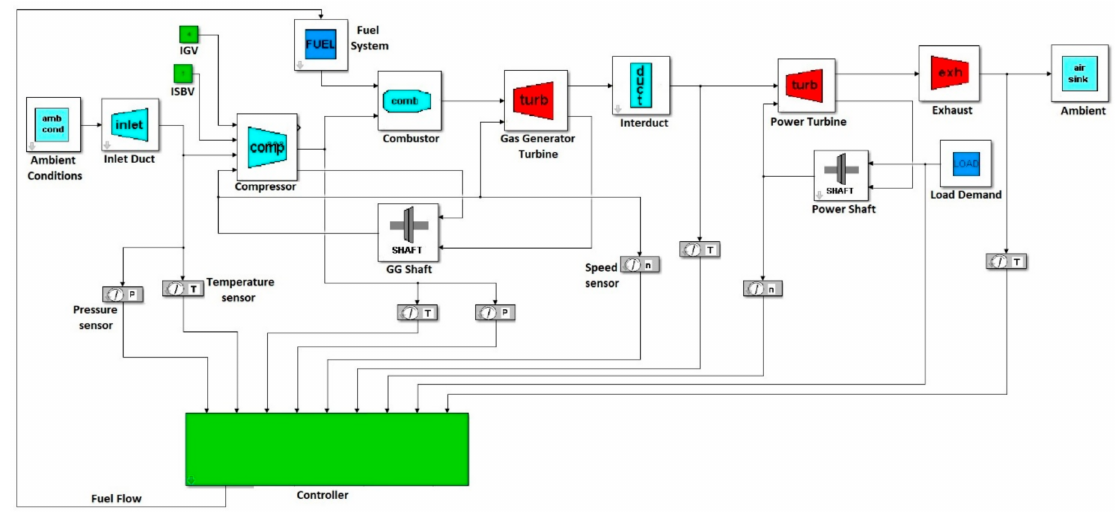
Figure 1. Twin-shaft gas turbine model in a Simulink